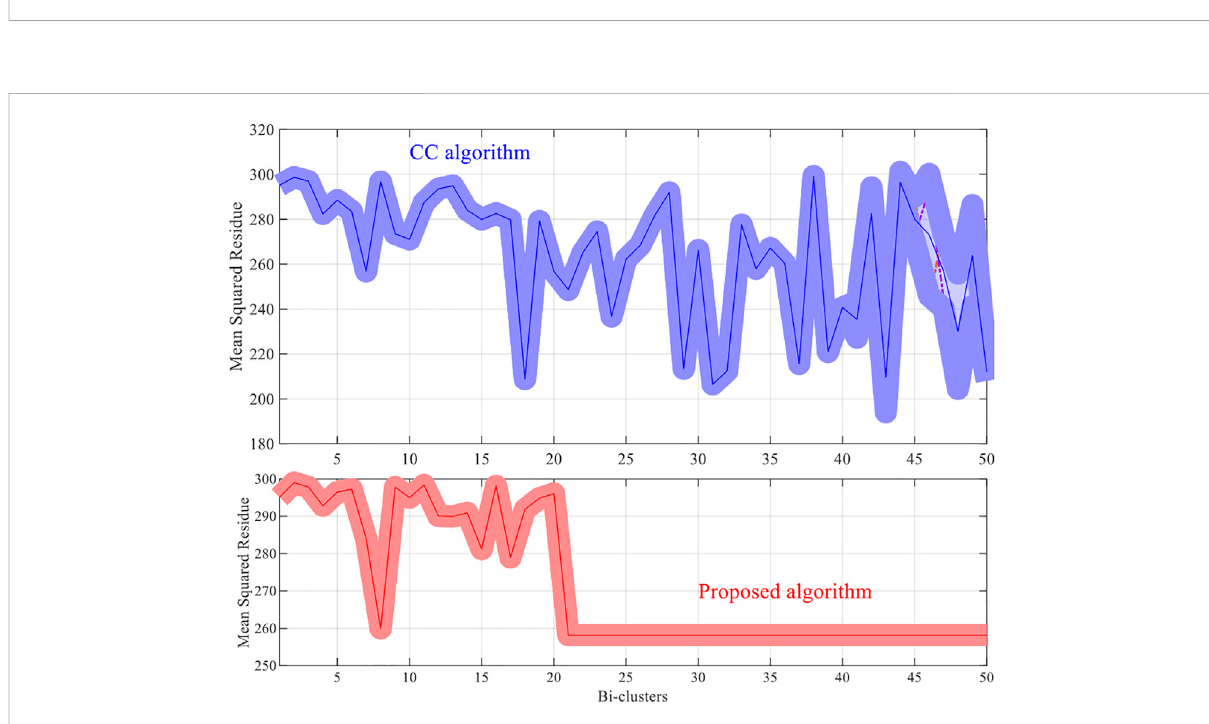
FIGURE 3 Results of the MSR scores of the west-2001